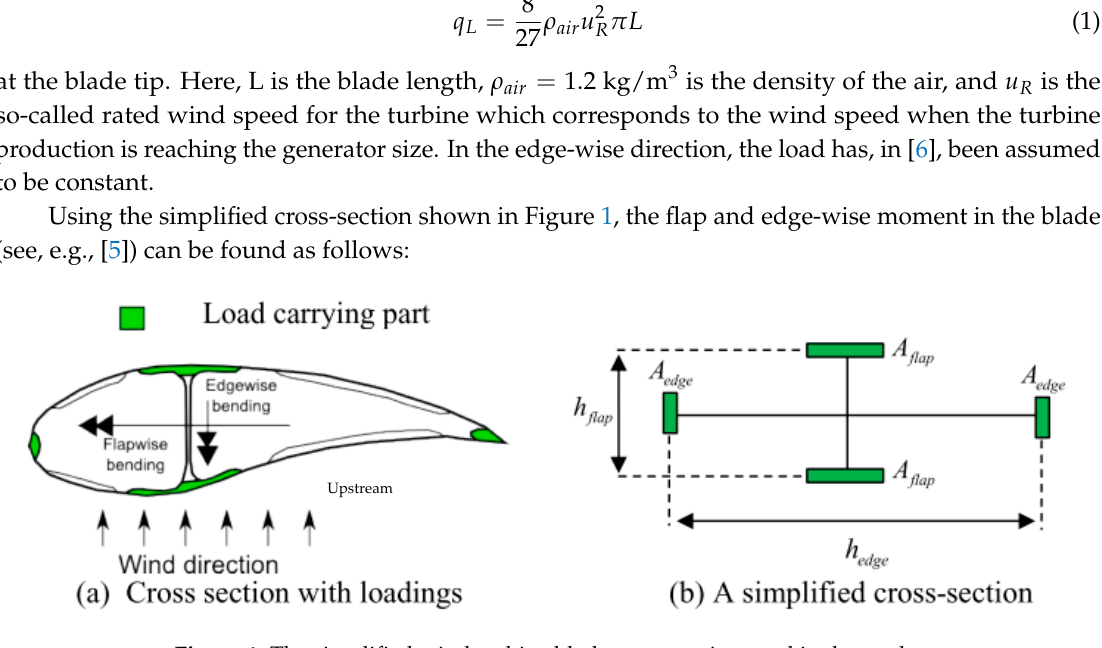
Figure 1. The simplified wind turbine blade cross-section used in the study.